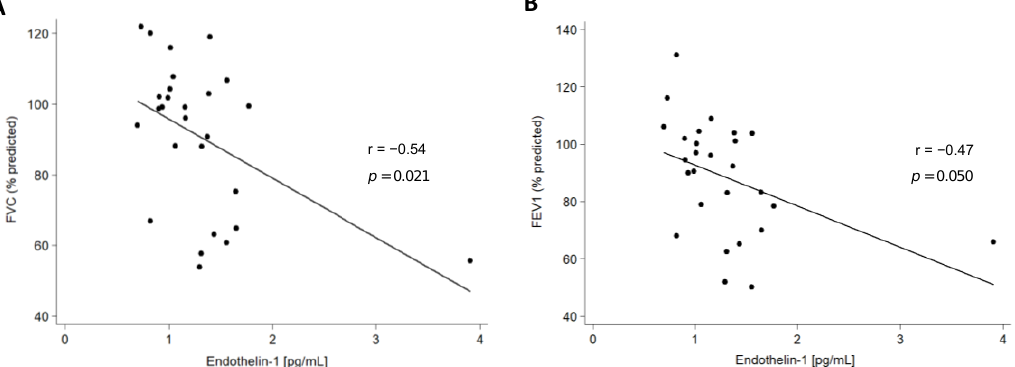
Figure 3. Partial correlation between ET-1 serum levels and FVC ( A ) and DLCO ( B ) in IPF patients.